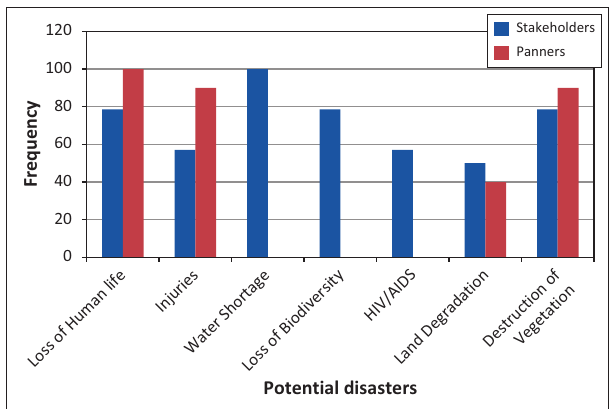
FIGURE 10: Potential disasters in Mzingwane District as perceived by